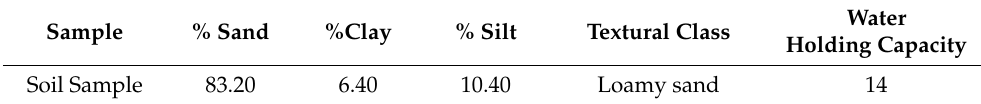
Table 19. Physical analysis of soil used in the screen-house experiment.